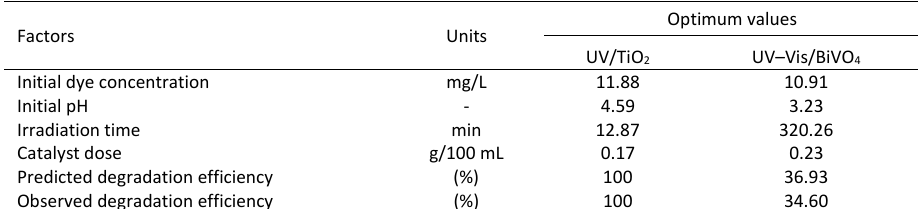
and UV–Vis/BiVO processes 2 4